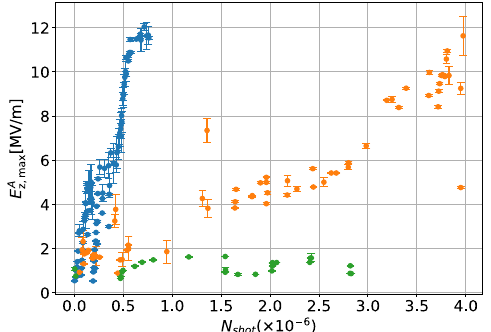
FIG. 3. The history of the peak value of the average accelerating gradient, E A z; , during the high power test for three cavities, max DAA2-1-uncoated (green), DAA2-2-DLC (blue), and DAA2-3- DLC(orange). Thehorizontalaxesdenotethenumber ofshotsofrf pulse injected to each cavity with a repetition rate of 50 [Hz]. The vertical axes denote the average accelerating gradient E A z; peak of the stored energy measured by pickup antenna P A c;